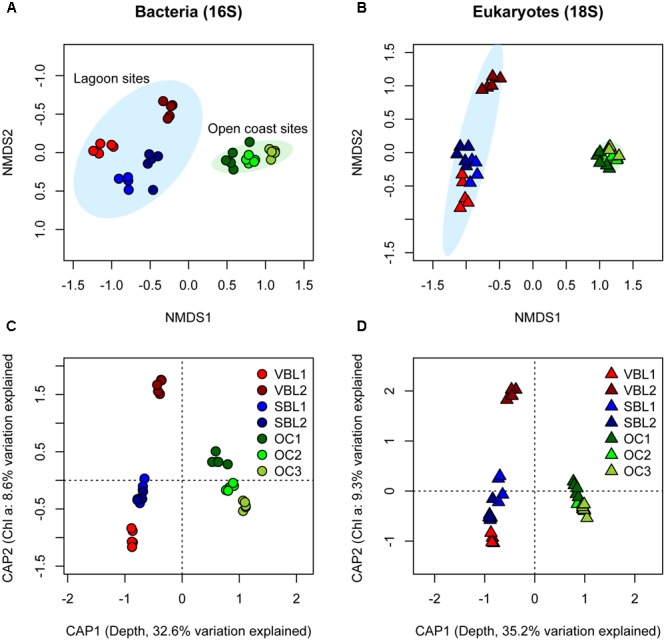
Ordinations based on 16S rRNA (A,C) and 18S rRNA (B,D) gene sequence variant relative abundances illustrate the variability in bacterial and eukaryotic community composition between sampling sites. In (A,B), non-metric multidimensional scaling (nMDS) display the distinct clustering of lagoon (blue ellipse) and open coast sites (green ellipse). Ellipses represent 95% confidence intervals of site position. In (C,D), distance-based RDA (Bray–Curtis distance metric used) constrained to water depth and leaf surface biofilm chlorophyll a content show the variability that can be explained by these two environmental variables.